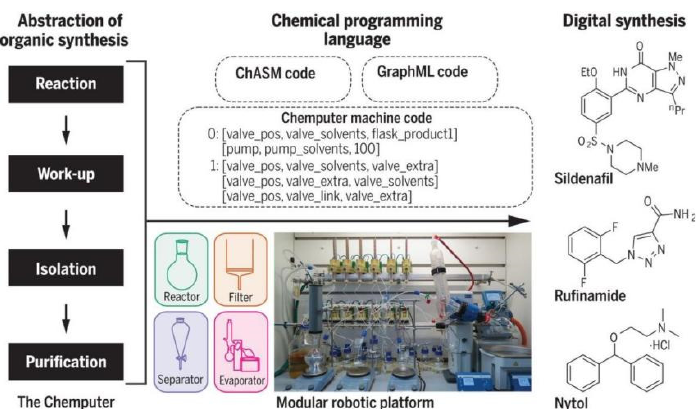
Figure 10. The Chemputer automated synthesis system and its application in drug synthesis. Reprinted with permission from ref. [58]. Copyright 2018, The American Association for the Ad- vancement of Science.